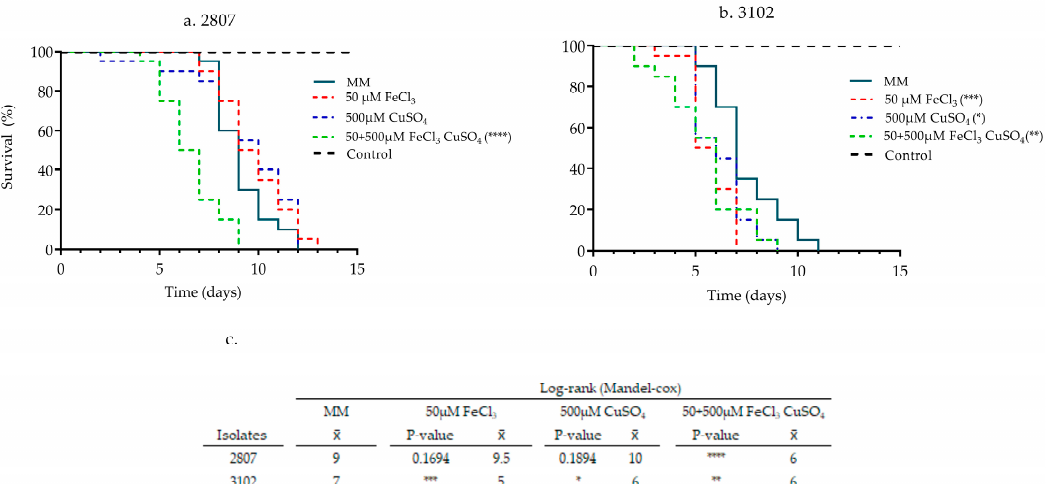
Figure 2. Effect of iron, copper, and their combination on the pathogenicity of two clinical isolates of C. neoformans : ( a ) 2807 and ( b ) 3102. ( c ) Results of the statistical survival test for the effect of the pre-incubation with 50 µ M iron, 500 µ M copper and their combination in G. mellonella . The table shows the results of the statistical test; p ≤ 0.05 (*); p ≤ 0.01 (**); p ≤ 0.001 (***); p ≤ 0.0001 (****). The results correspond to three biological replicates; x : average